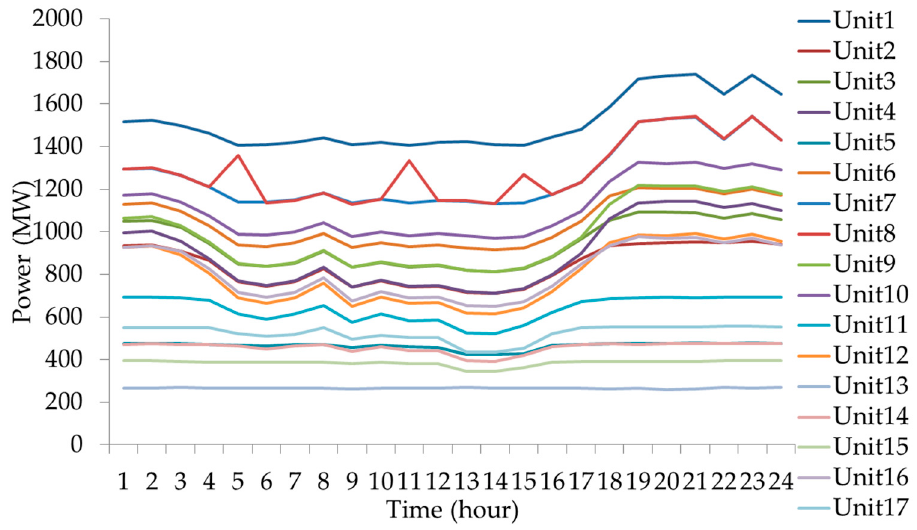
Figure 6. Thermal power outputs in Case 1.